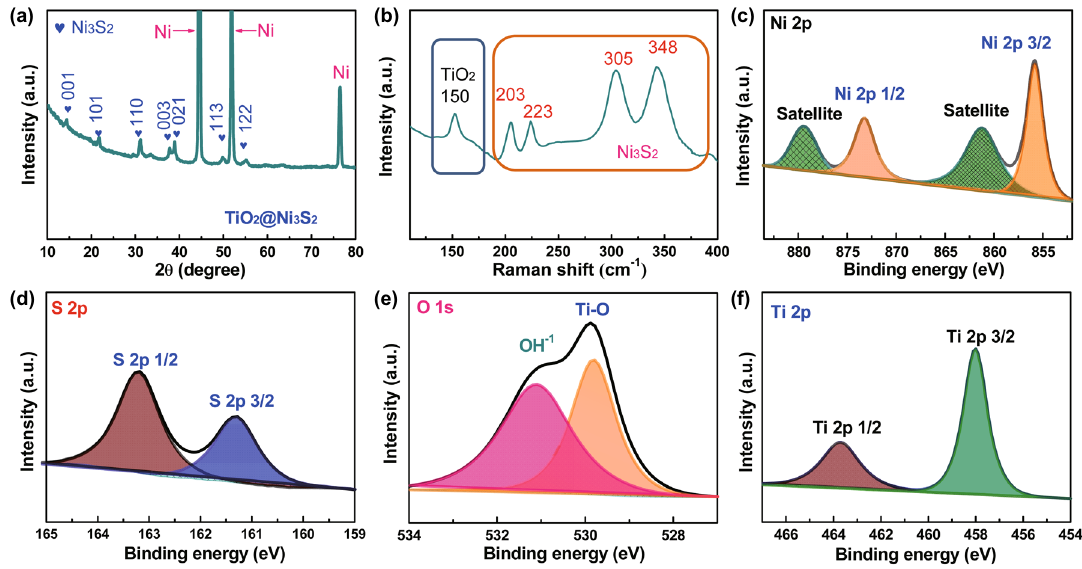
Fig. 3 a XRD patterns, b Raman spectrum, c core-level Ni 2 p XPS spectra, d core-level S 2 p XPS spectra, e O 1 s XPS spectra, and f Ti 2 p XPS spectra of TiO 2 @Ni 3 S 2 core/branch